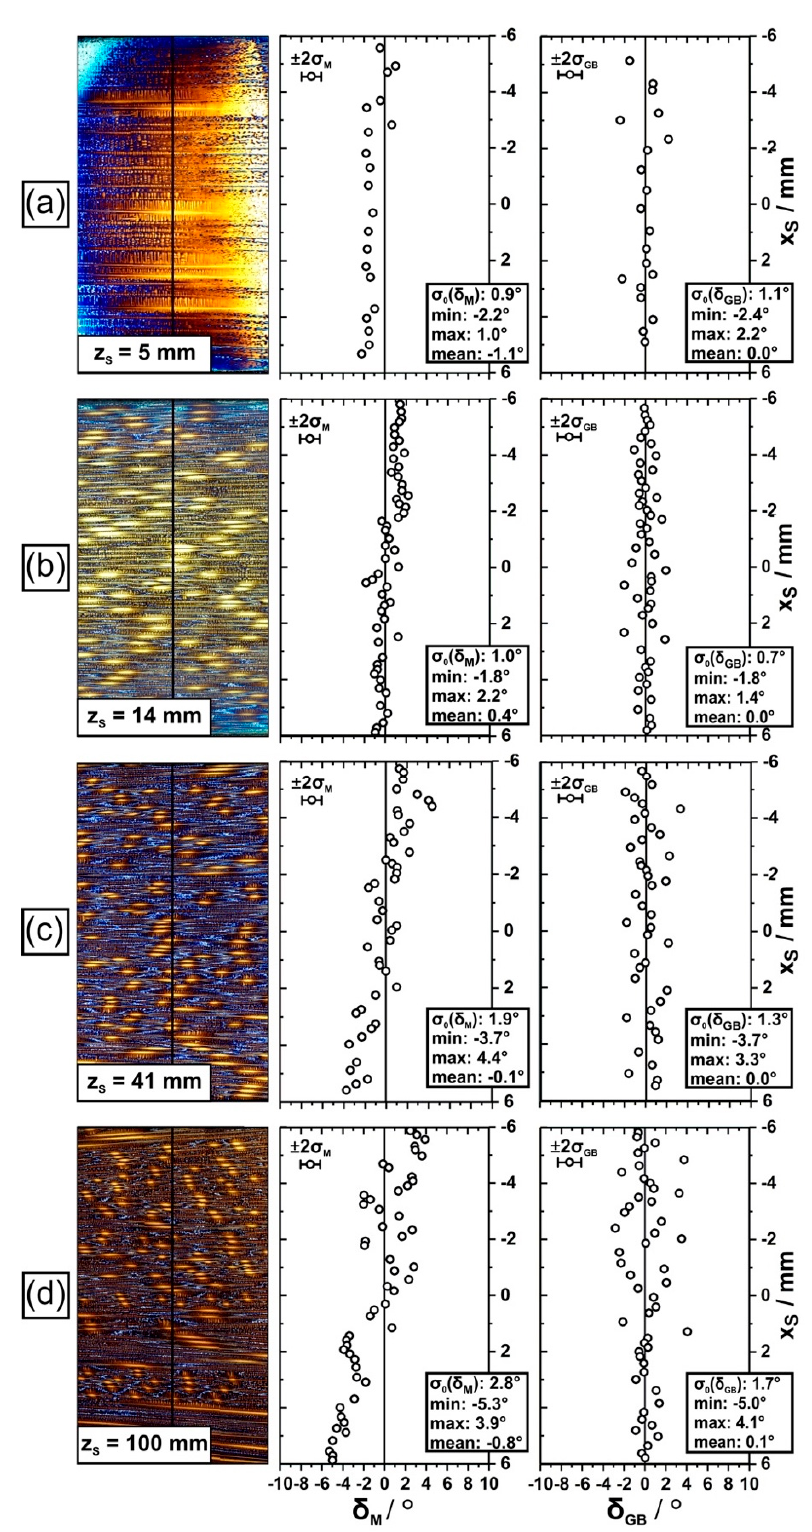
Figure 6. Evaluation of dendrite misorientations for various z S positions in an SX cylinder prepared with a withdrawal rate of 180 mm/h. ( a ) Seed crystal: z S = 5 mm. Newly-grown crystal: ( b ) z S = 14 mm, ( c ) z S = 41 mm, ( d ) z S = 100 mm.